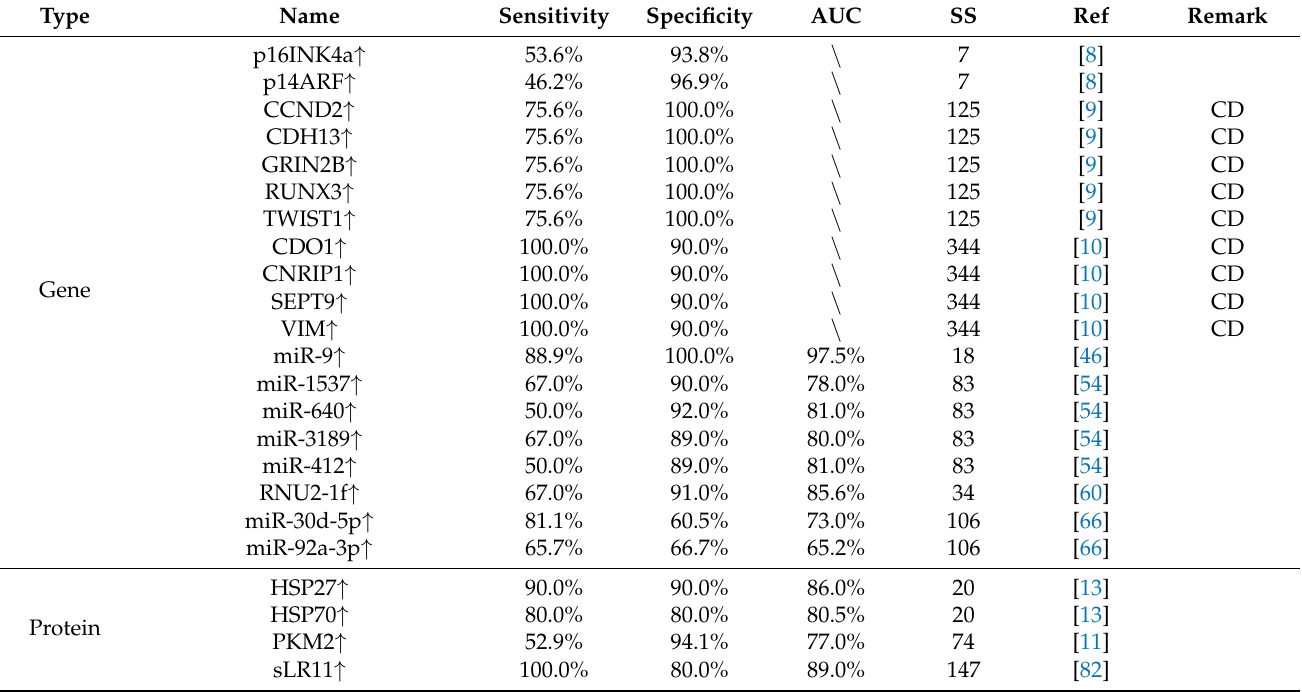
Table 1. Potential diagnosis biomarkers in human bile with